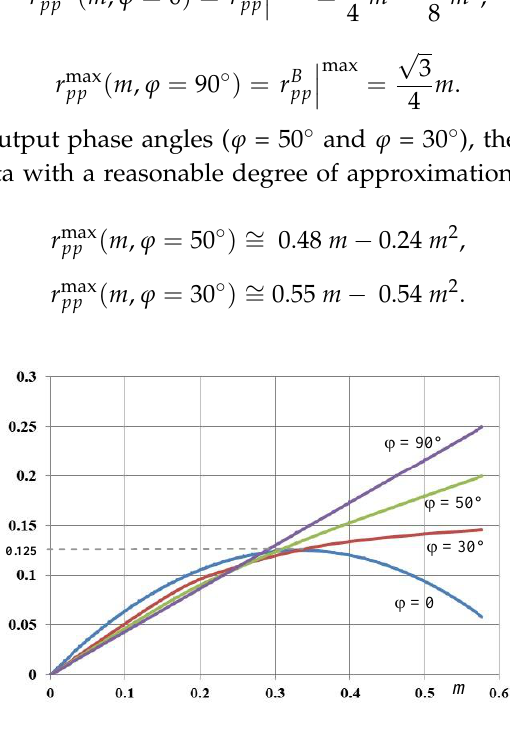
Figure 5. Maximum of normalized peak-to-peak voltage ripple amplitude vs. modulation index for different output phase angles.